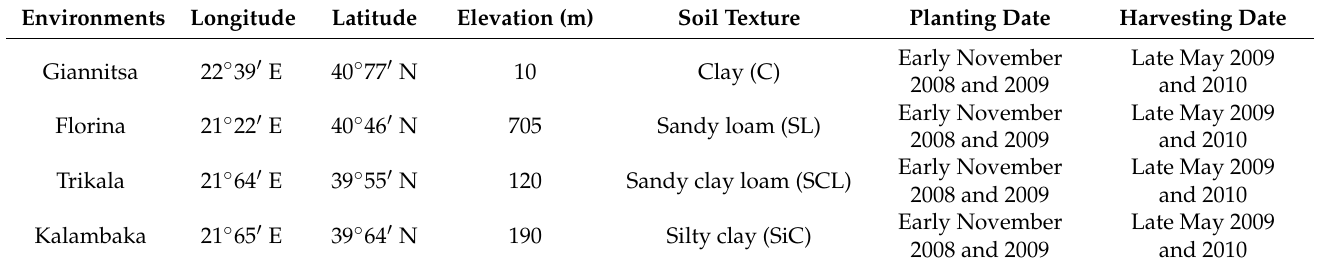
Table 7. Coordinates, altitude, soil type, and cultivation information for the environments of the experiment.